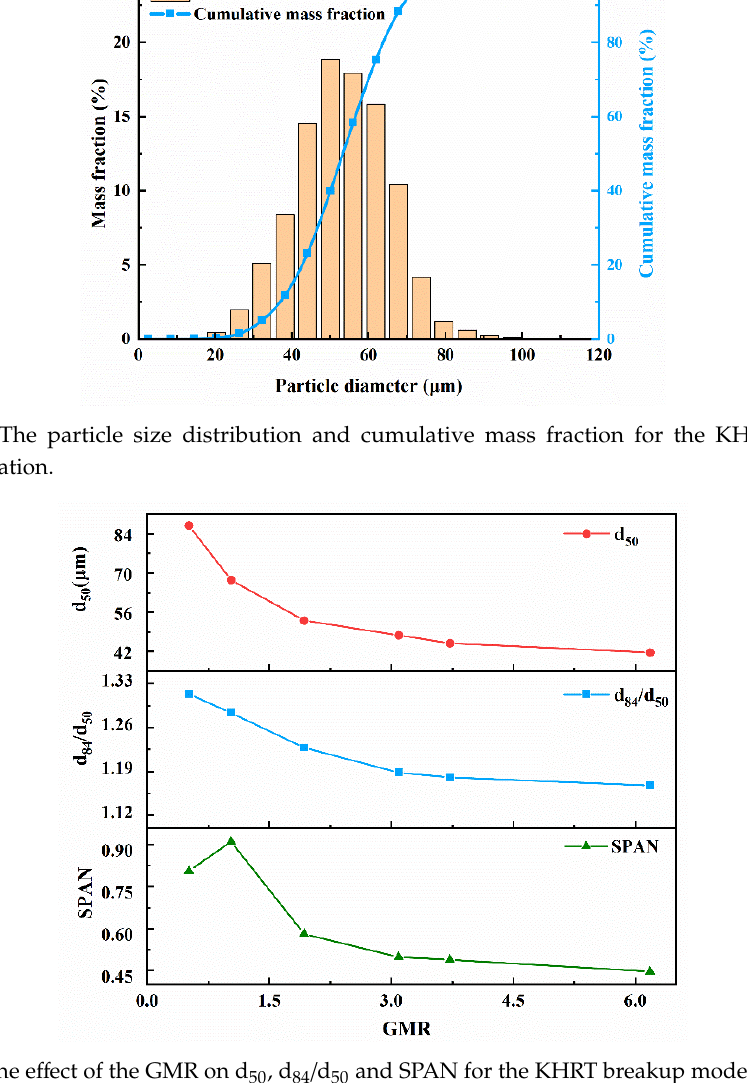
Figure 14. The effect of the GMR on d 50 , d 84 /d 50 and SPAN for the KHRT breakup model simulation.